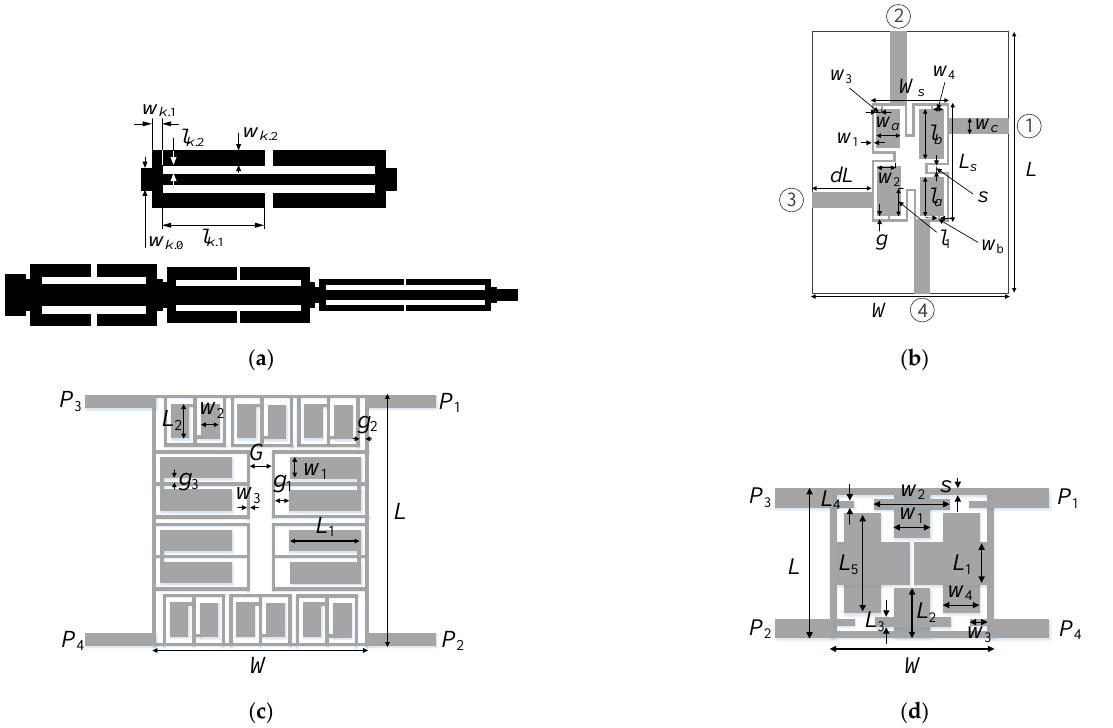
Figure 2. Verification structures: ( a ) three-section impedance matching transformer: (top) compact microstrip resonant cell (CMRC), (bottom) geometry of the circuit using CMRCs (Circuit I) [54]; ( b ) compact branch-line coupler (Circuit II) [55]; the numbers in circles show ports; ( c ) branch-line coupler with microstrip cells (Circuit III) [56], ( d ) compact branch-line coupler with unequal power division (Circuit IV) [57]. Table 2. Details of microwave structures used as verification cases.